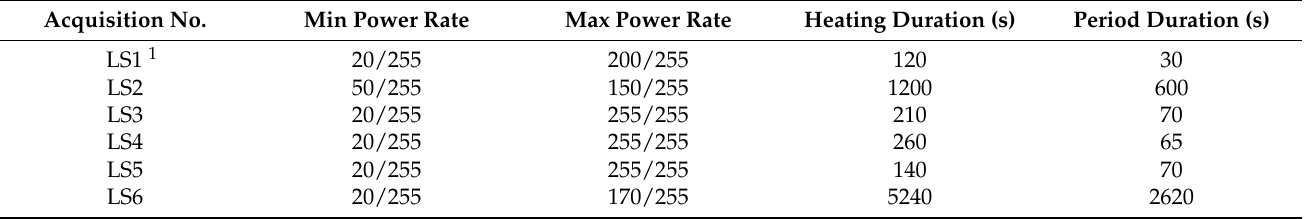
Table 7. Optical lock-in acquisition protocols applied to the CF-PET-CF sandwich